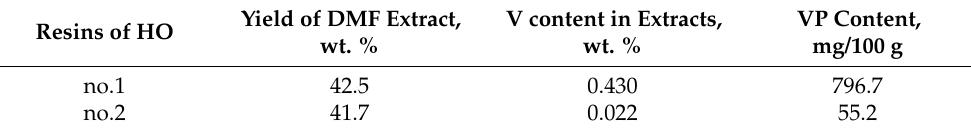
Table 3. Characteristics of DMF extract of the resins.